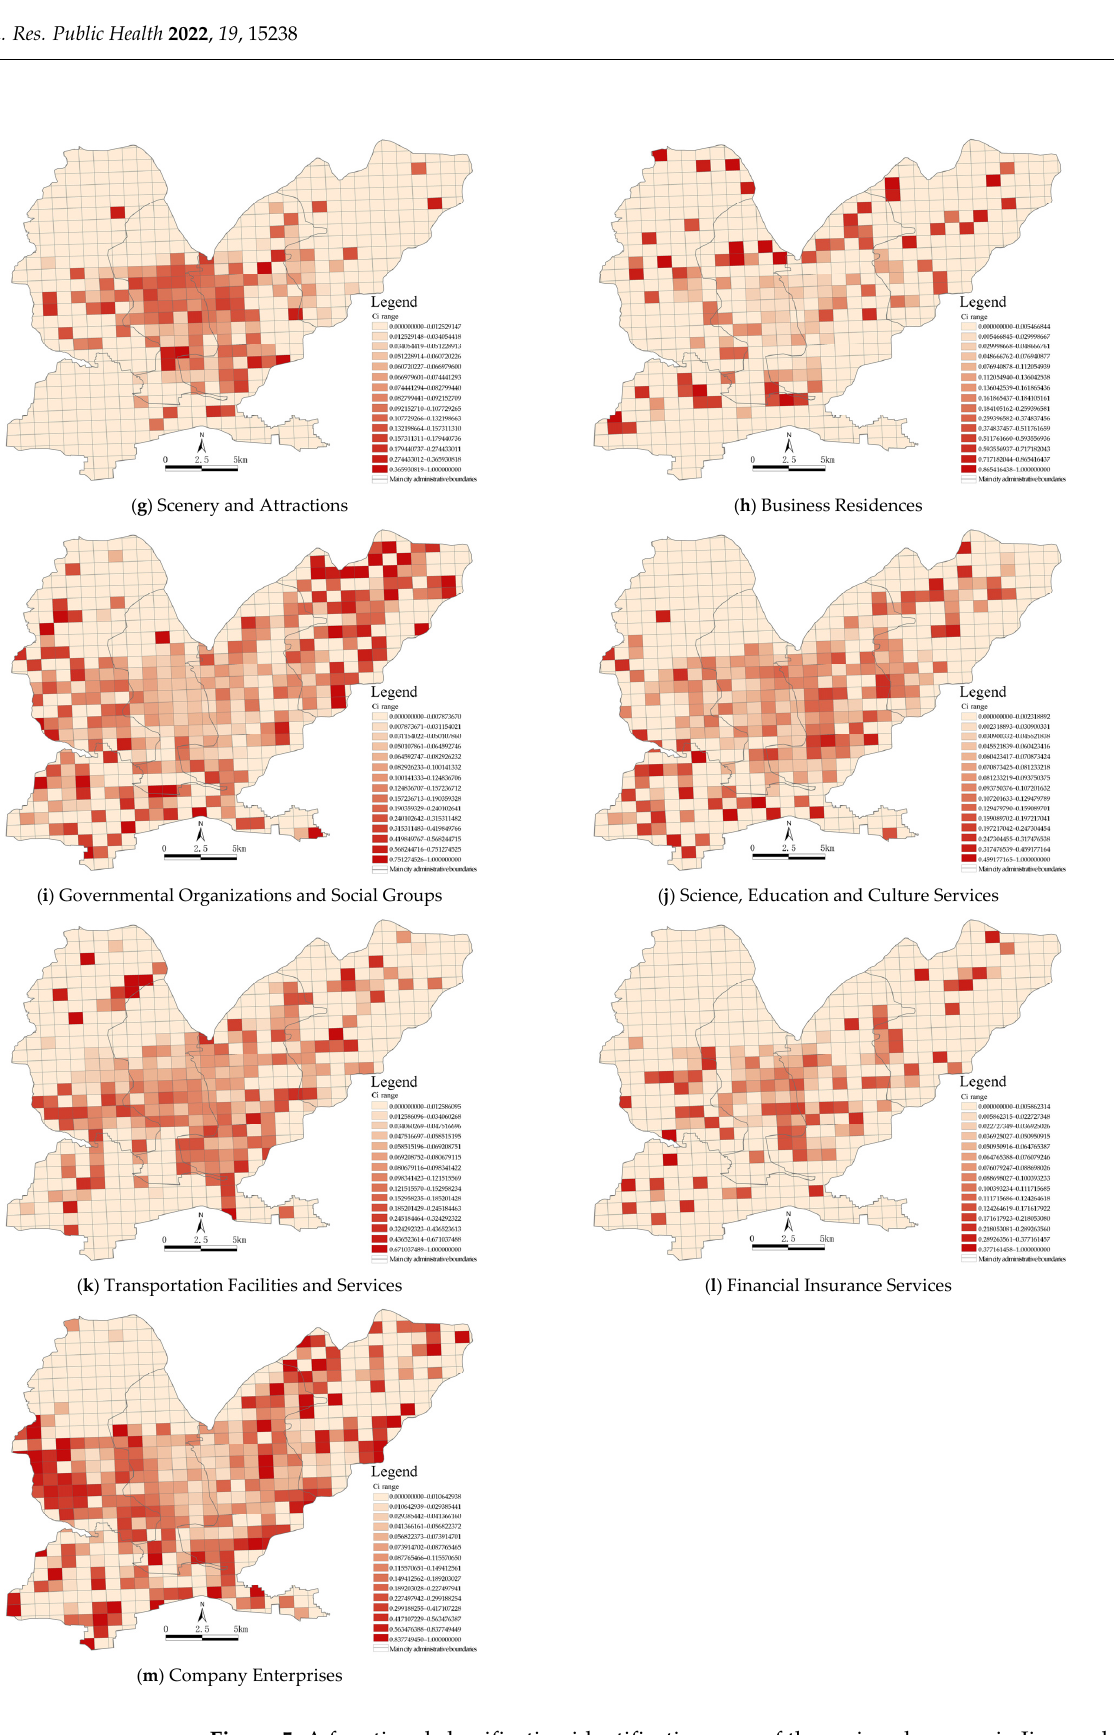
Figure 5. A functional classification identification map of the main urban area in Jiaozuo based on POI data ( C i